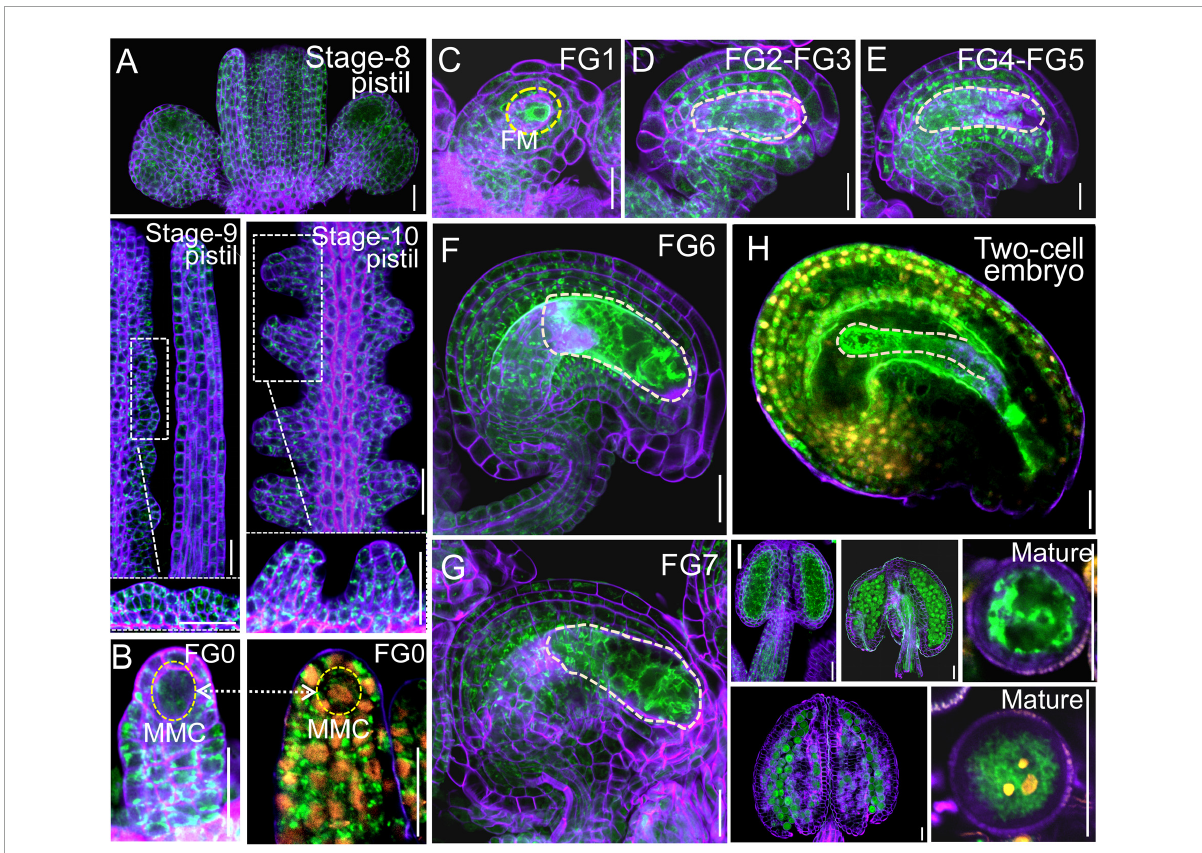
FIGURE2 VHA-a3 is constitutively expressed in reproductive organs. Representative stage-8, stage-9, stage-10 pistil (A) , ovules during FG0 stage (B) , FG1 stage (C) , FG2-FG3 stage (D) , FG4-FG5 stage (E) , FG6 stage (F) , FG7 stage (G) , two-cell embryo (H) , anthers and mature pollen grain (I) from the Pro VHA-a3: VHA-a3-GFP plants. The nuclear staining with DAPI in FG0 stage (B) to demonstrate that MMC is present in this developmental stage. Yellow dotted circles in (D–G) indicate the embryo sac and in (H) indicate the two-cell embryo; Orange dots indicate the nucleus by DAPI staining of mature pollen grain. The purple part is the outline of pollen grains stained with FM4-64. Bars = 20 µ m. MMC megaspore mother cell, FM functional